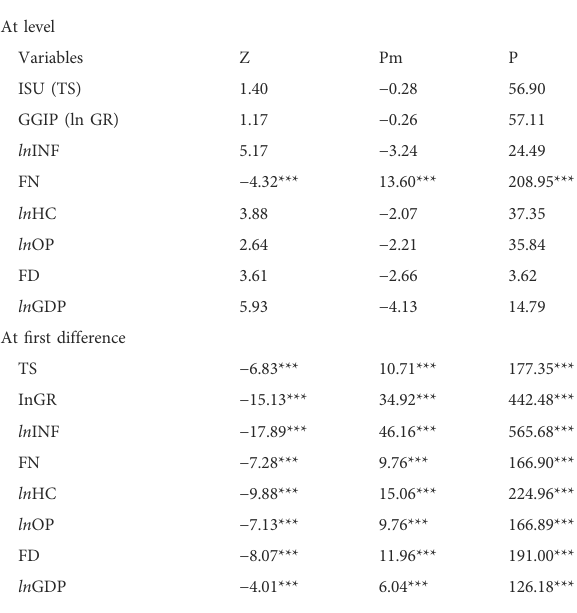
TABLE 3Stationarityandunit-rootoutputs:Augmented Dickey-Fuller (ADF) test. Stationary